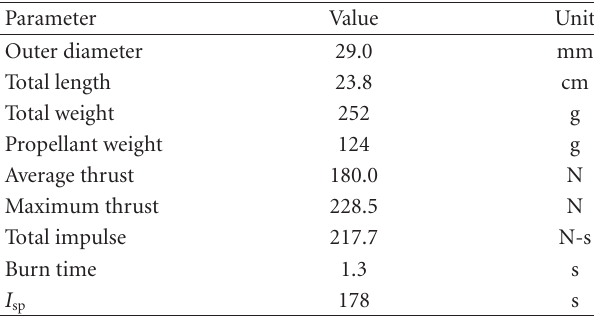
Table 4: Aerotech H180 motor specifications [27].